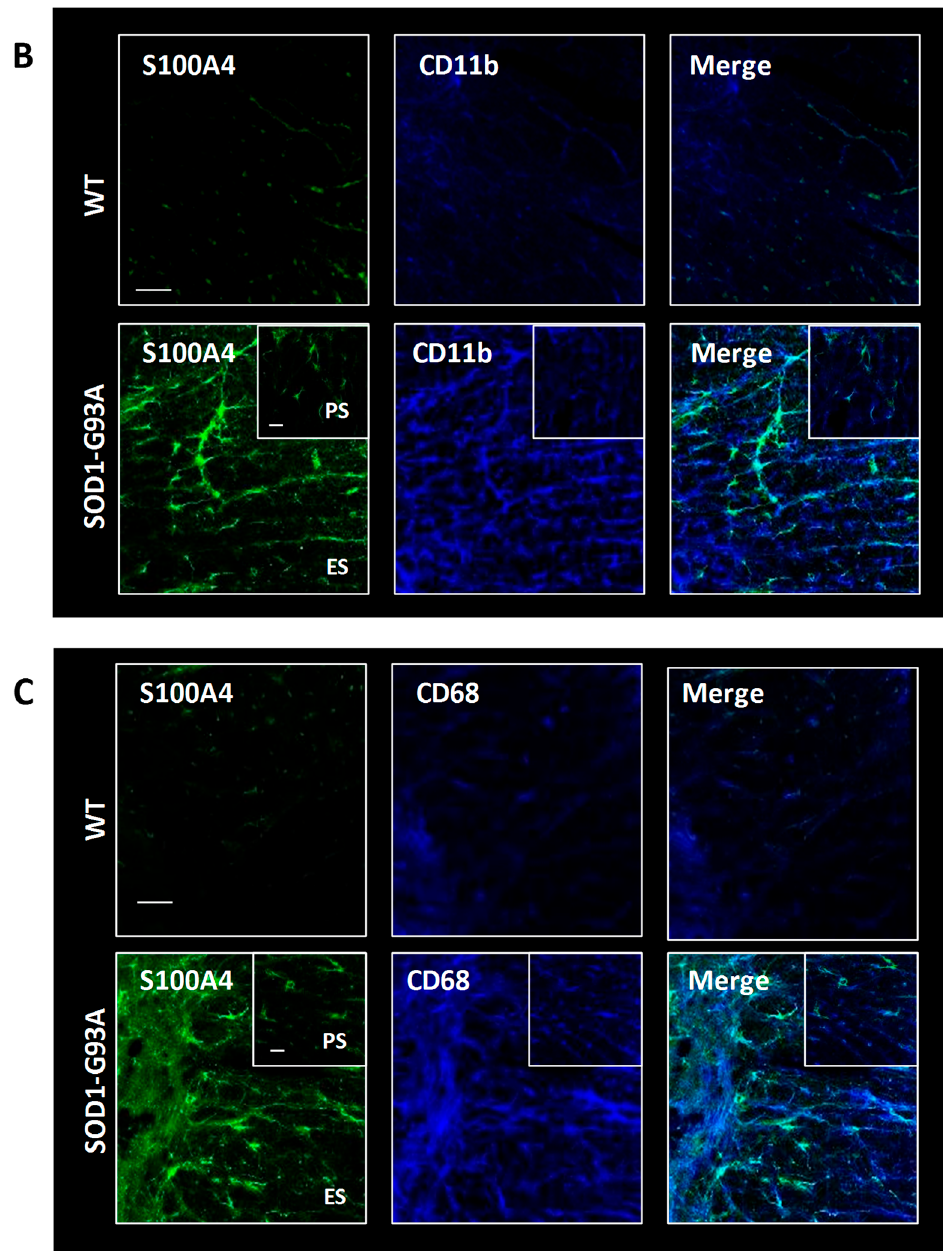
Figure 6. S100A4 increases in astrocytes and microglia/macrophages in the lumbar spinal cord from SOD1-G93A rats. Representative images of double immunofluorescence confocal analysis with anti-S100A4 (in green) and anti-GFAP (in red, ( A )), anti-CD11b (in red, ( B )), and anti-CD68 (in red, ( C )) in the grey and white matter of the lumbar spinal cord from wild-type (WT) and end-stage (ES) SOD1-G93A rats. Insets show images from pre-symptomatic (PS) SOD1-G93A rats. n = 3 animals per group. Scale bars: 50 μ m.